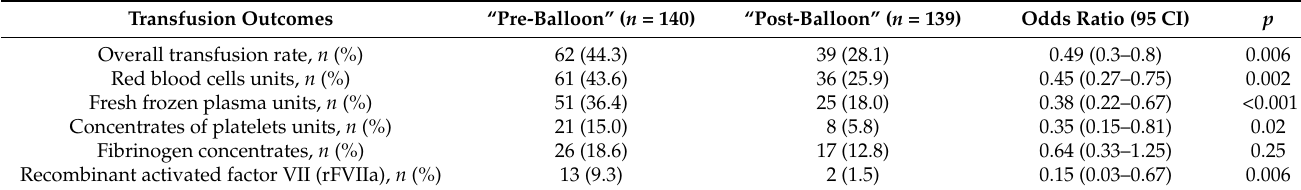
Table 3. Requirement rates of transfusion with details by blood product. Related odds ratios are expressed with their 95% confidence intervals.